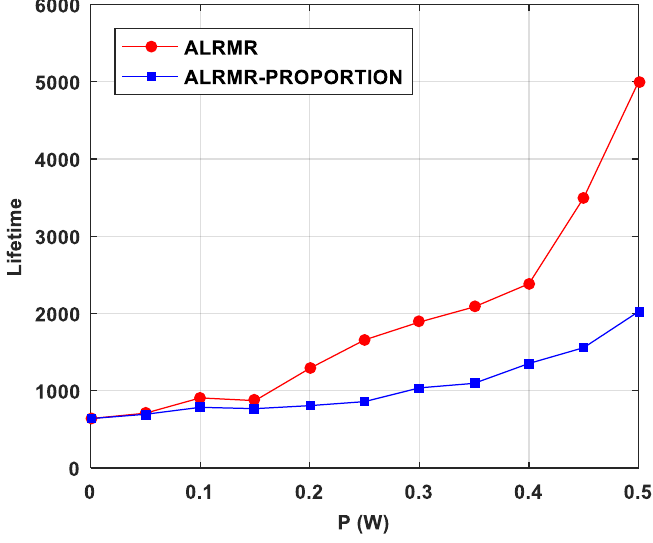
Figure 4. Network lifetime with di ff erent values of P